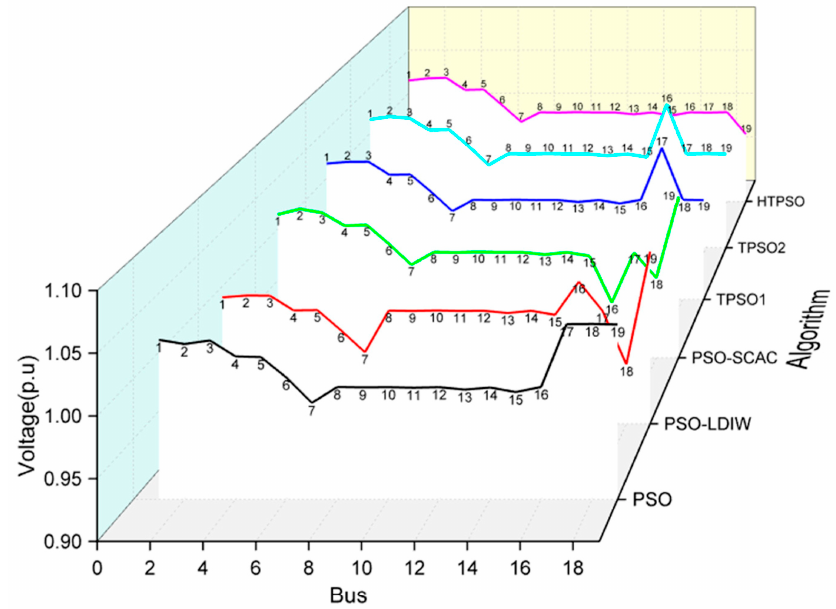
Figure 7. Voltage distribution